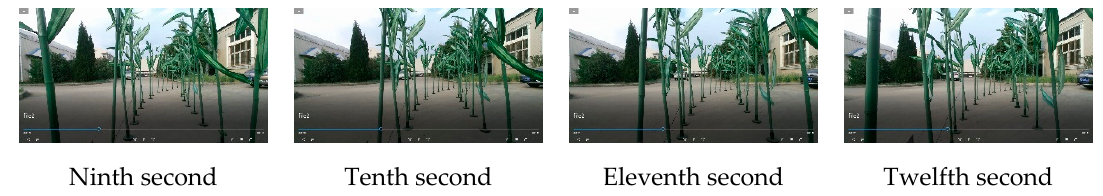
Figure 20. The real-time process during machine movement.